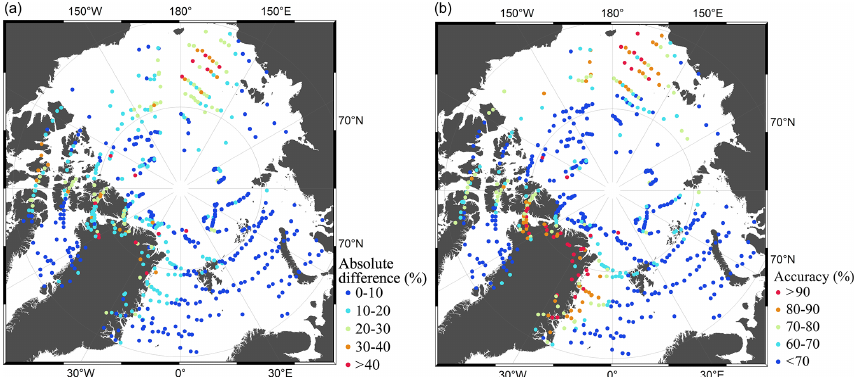
Figure 16. Plots of comparisons between the S1-derived sea ice cover and other data in the period from 25 July to 5 August 2019. (a) Absolute difference between the S1-derived sea ice concentration and the AMSR2 data. (b) Accuracy between the S1-derived sea ice cover results and the IMS data.